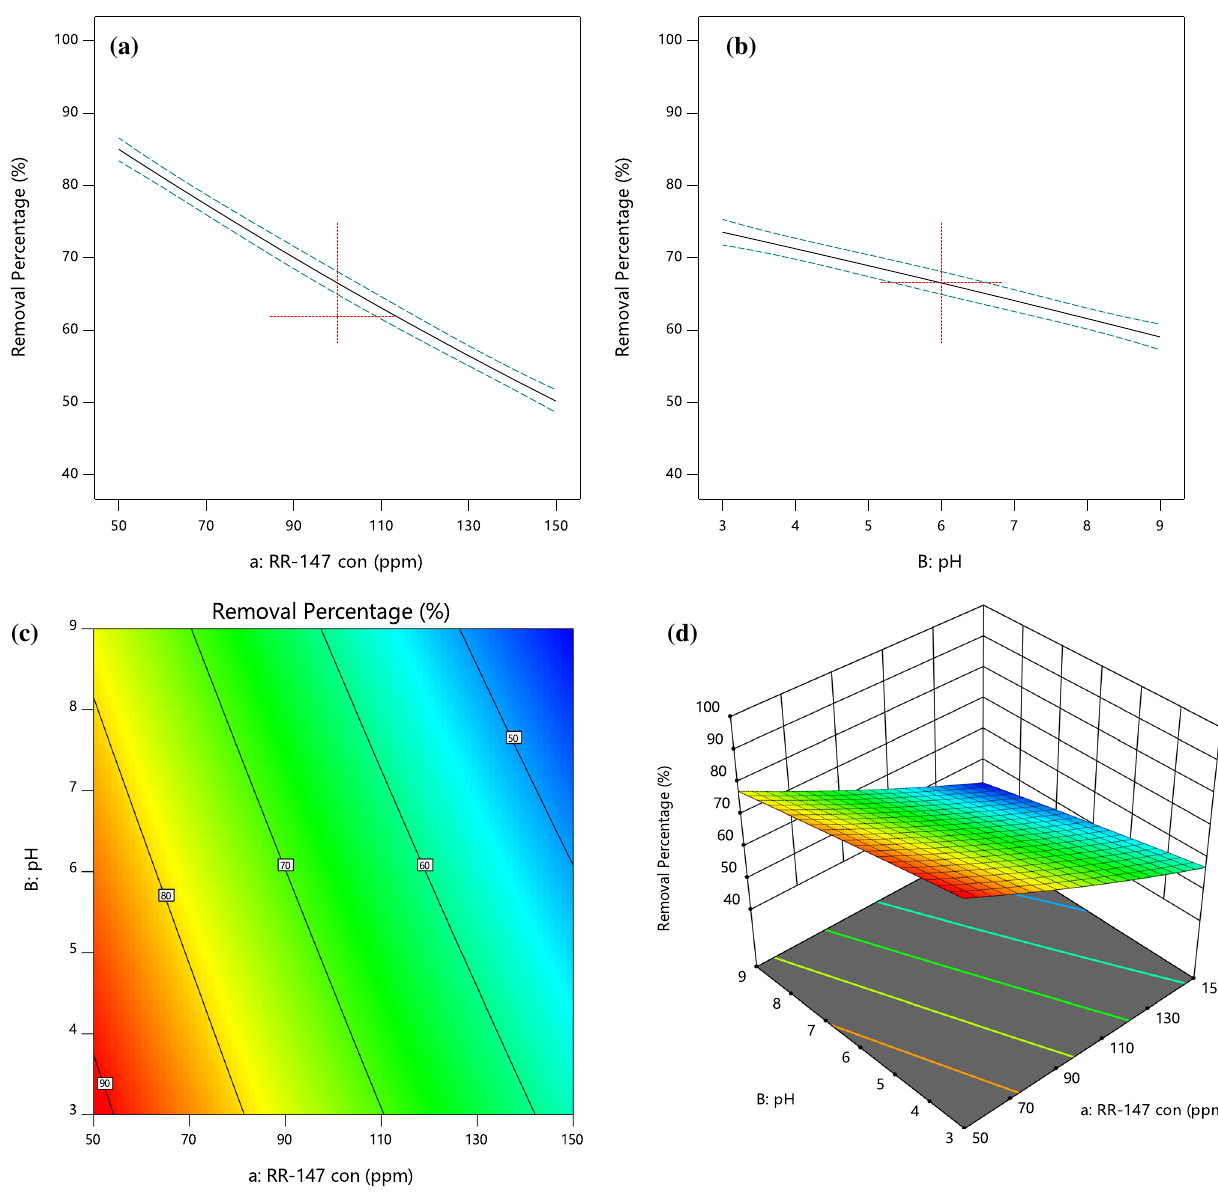
Fig. 6 Influence of various dye concentration a with different solution pH value b on the dye removal rate (%), c contour plot and d response surface plot according to RSM